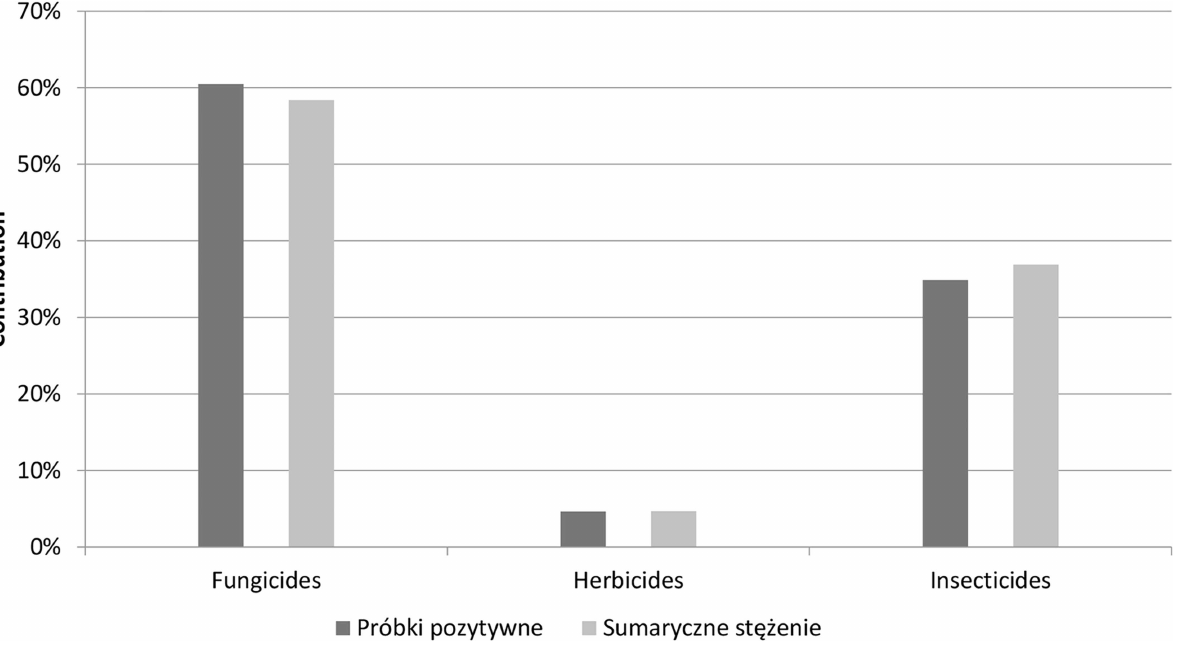
Fig 2. Groups of pesticides identified in the analyzed